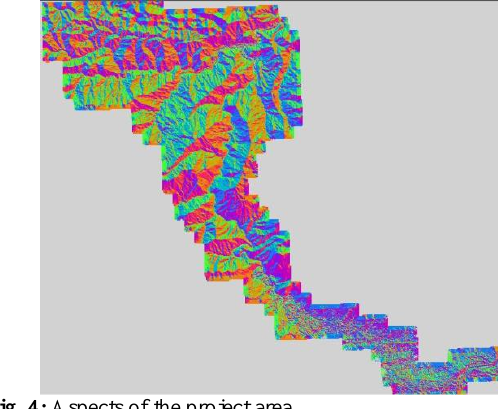
Fig. 4: Aspects of the project area